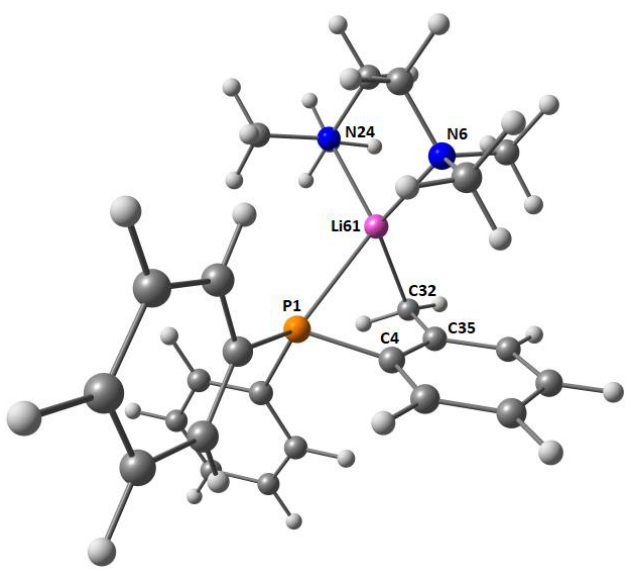
Figure 3. Optimized structure of 1a-Li . Selected bond lengths (Å) and angles ( ◦ ): P1-Li61 2.6383, N6-Li61 2.1093, N24-Li61 2.1112, C32-Li61 2.1275, C35-Li61 2.4864, C4-C35 1.4373, N6-Li61-N24 86.78, C32-Li61-P1 78.34, N24-Li61-P1 118.31, N6-Li61-P1 115.43, N24-Li61-C32 135.31, N6-Li61-C32 125.33, C35-Li61-P1 65.11.